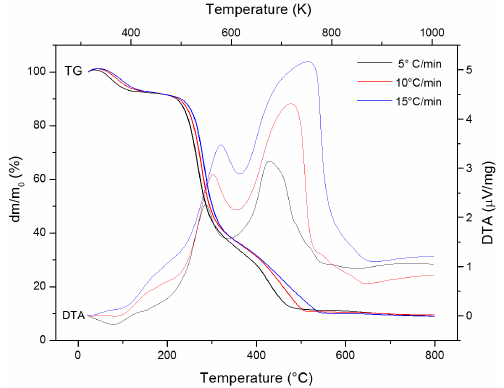
Figure 7. TG/DTA curves of In Natura BF at different heating rates. Bibliographic source: Author.